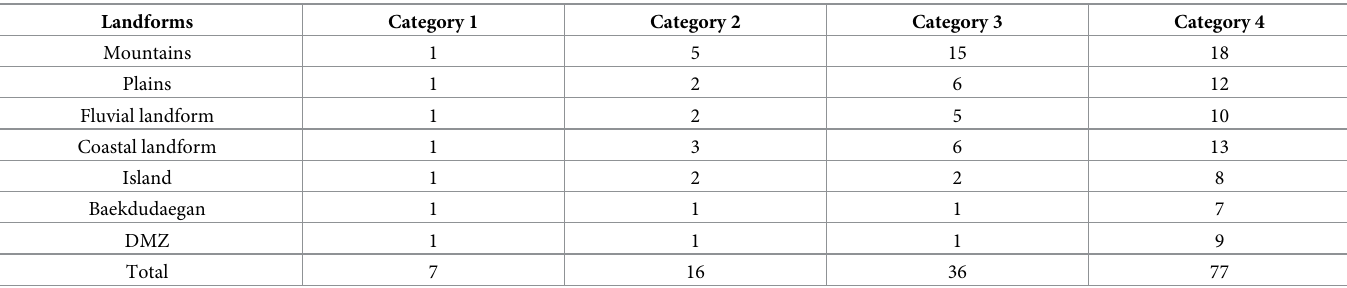
Table 3. Number of landform types.